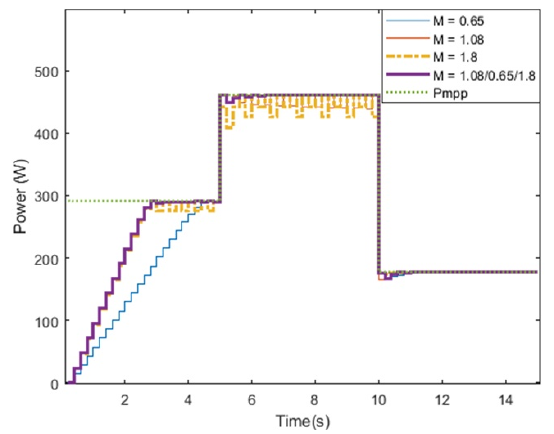
Figure 6. Power tracking curves of di ff erent M